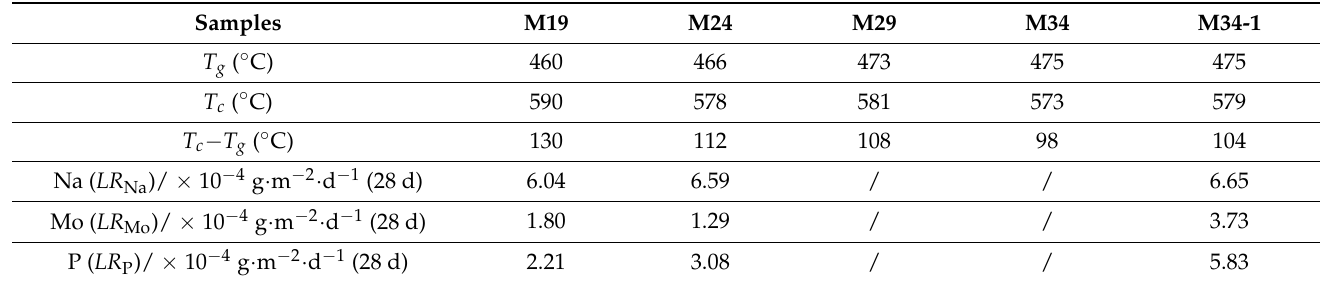
Table 5. Thermal parameters and leaching rates of the samples in the Mz series.